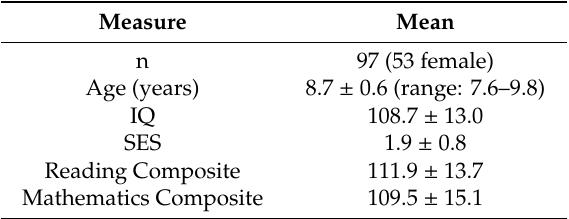
Table 1. Participant demographics and scholastic